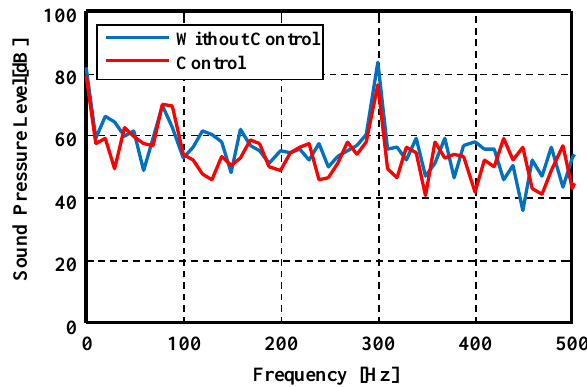
Figure 9. Adaptive filter 200 Hz.